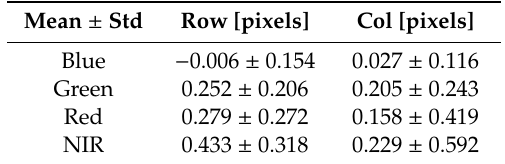
Table 4. Di ff erences of coordinates between MS and PAN images after CCD o ff set compensation.